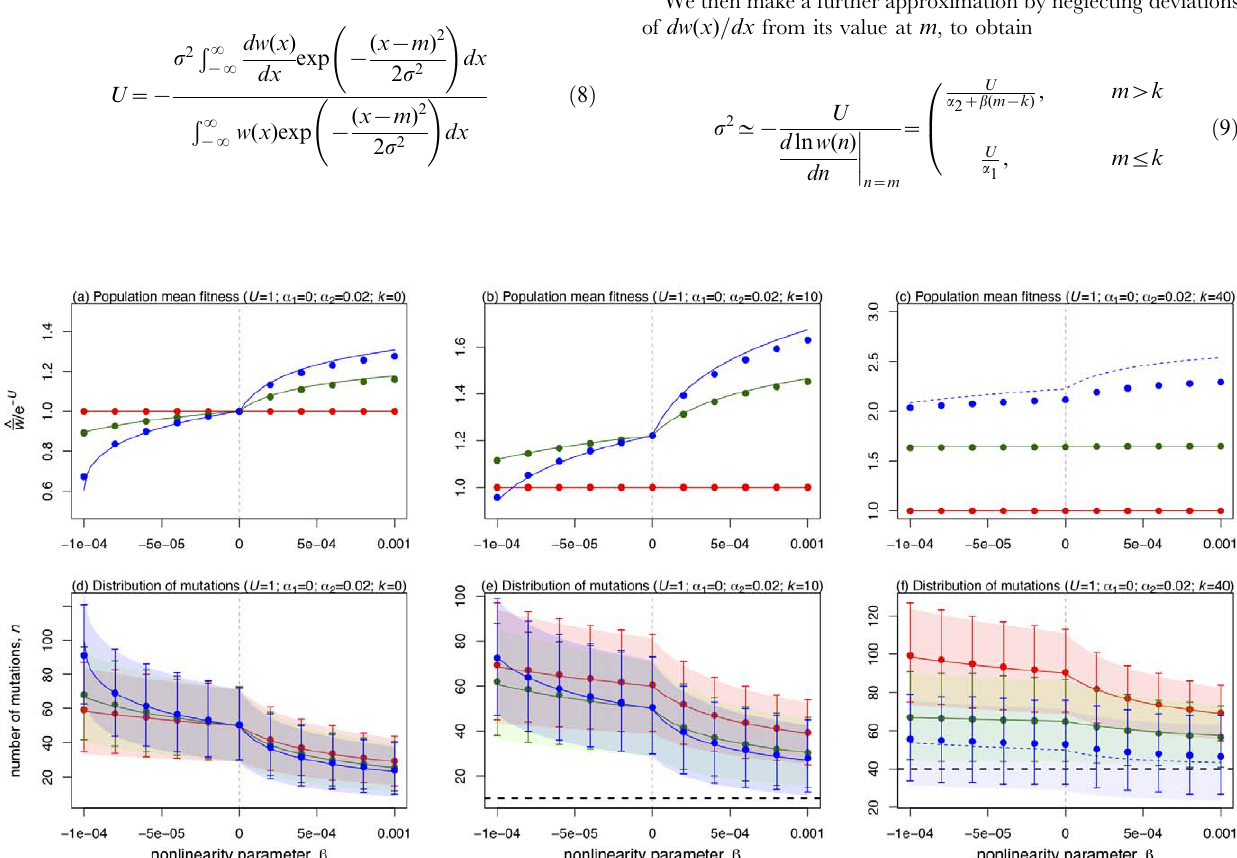
Figure 6. Results for populations at mutation-selection equilibrium. The x-axes show variation in the parameter b , which determines the epistasis following the first k mutations carried. Note that different scales are used for negative and positive values. The analytical results are found in Table 3. Results are shown in the special case a 1 ~ 0 , such that the first k mutations have a negligible effect on ~ a fitness (as in Figure 5), and U (cid:2) ~ U , a (cid:2) 2 (Eq. 4). All conventions as Figure 3. 2